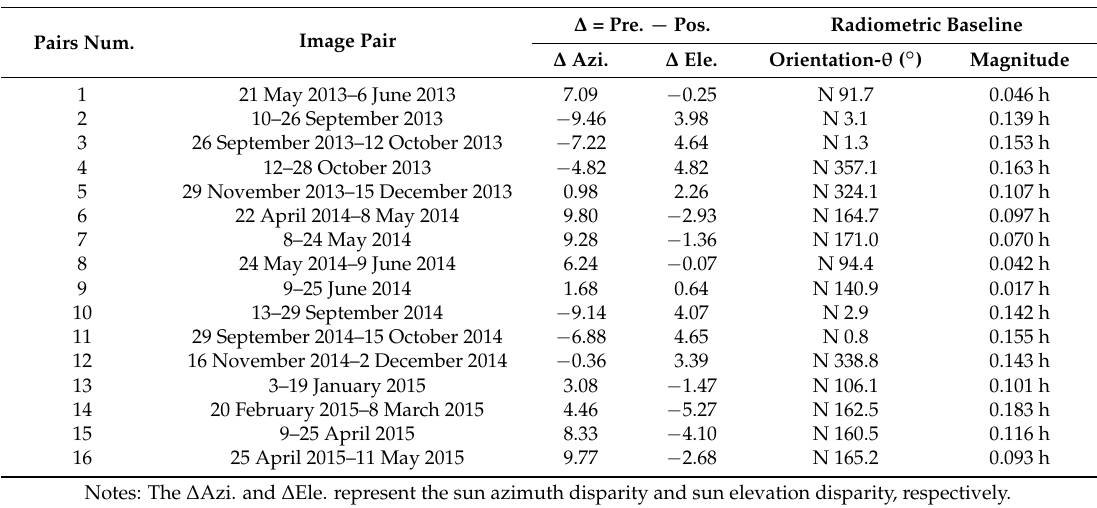
Table 2. Radiometric baseline list of the Landsat 8 correlation image pairs. Pairs Num. Pairs Num. Image Pair